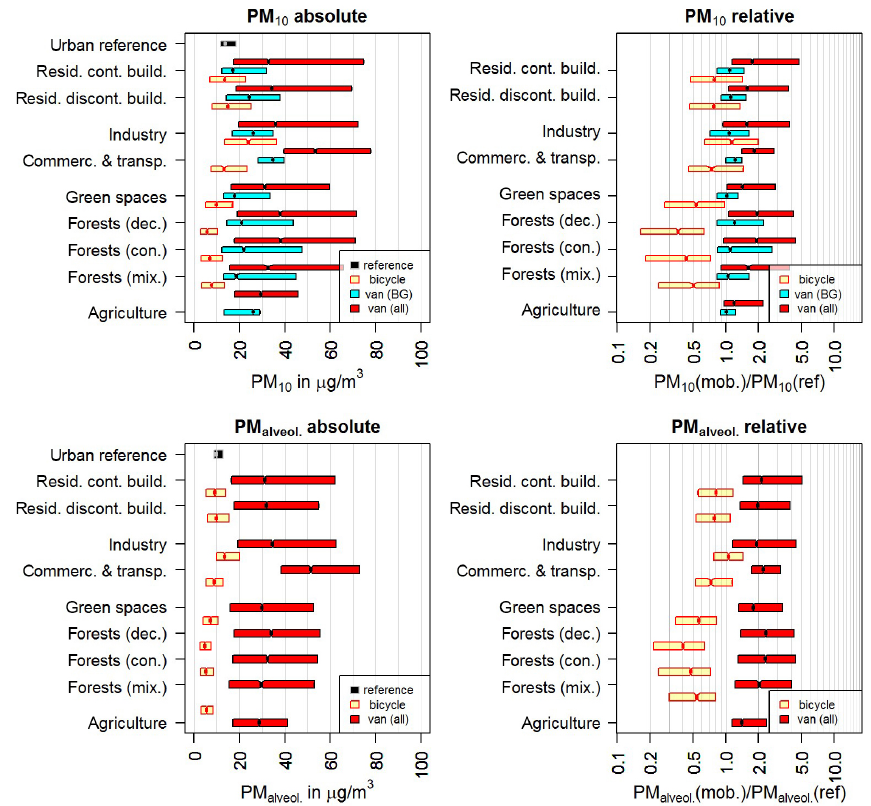
Figure 10. Particulate mass concentrations (left) and concentration ratios (right) for different land surface types and different observation platforms compared to the measurements in Neukölln: top – PM 10 , bottom –